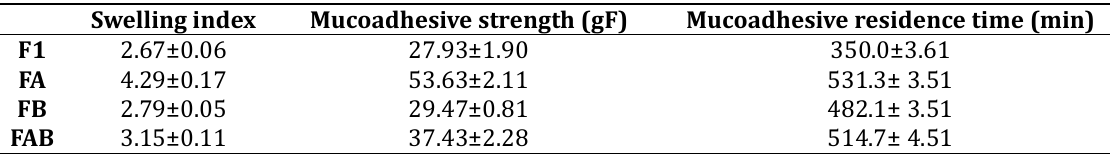
Table III. The results of three buccal film response for optimization Swelling